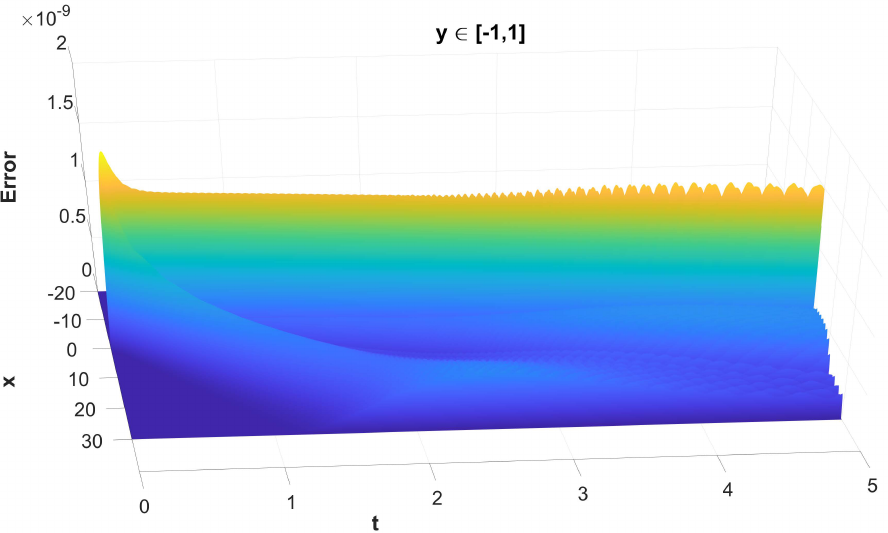
Figure 11. The maximum, along y , absolute error of the solution versus t and x with the use of finite difference schemes for the spatial semi-discretisation.